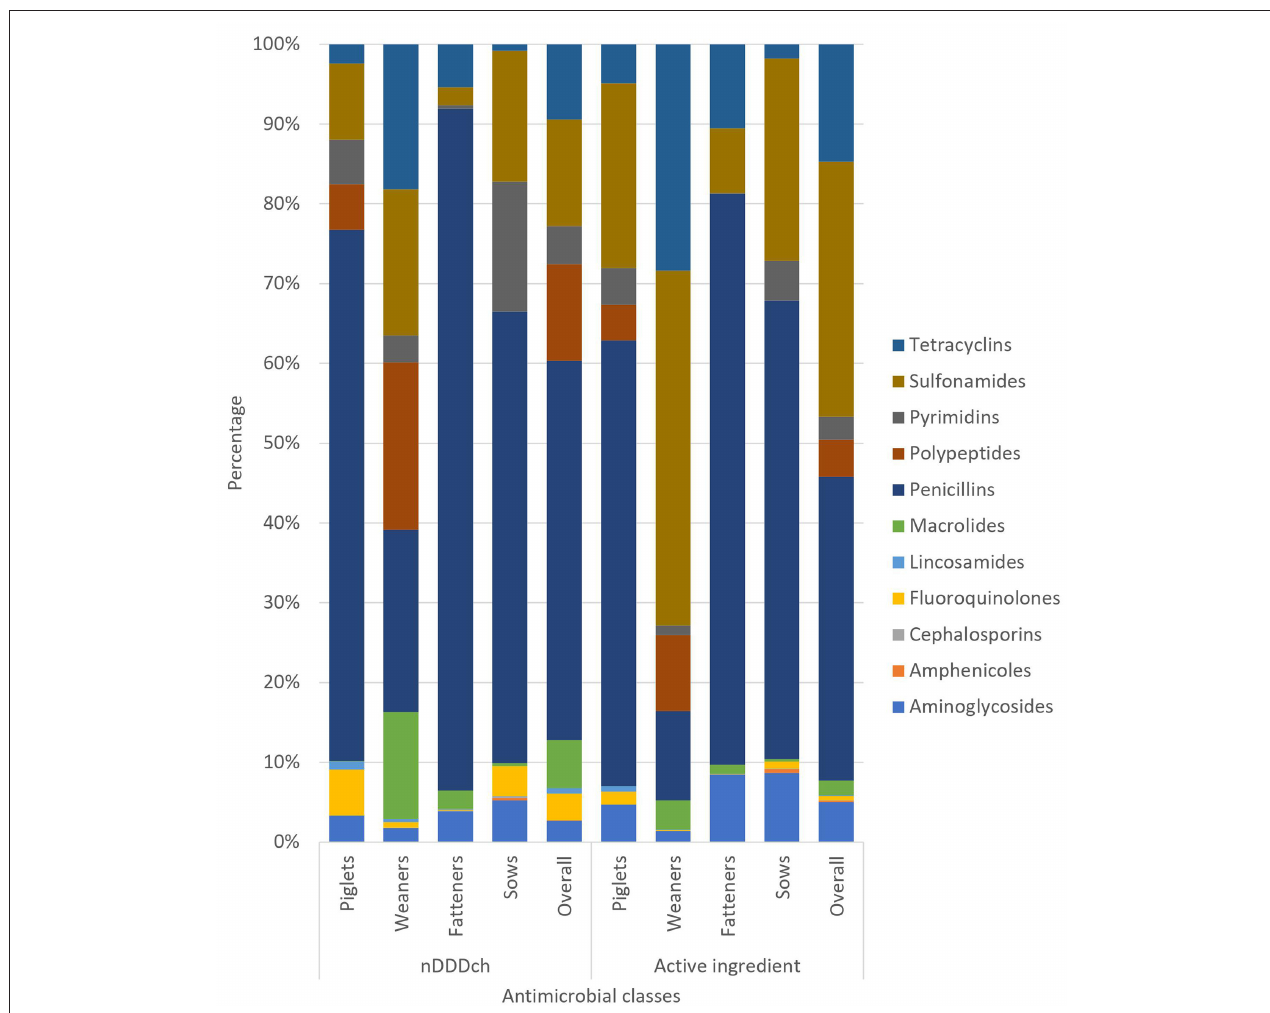
FIGURE 1 | Relative distribution of the used antimicrobial classes analyzed either as nDDDch or as active ingredient of the overall study population and separated among the different age categories (piglets, weaners, fatteners, and sows).